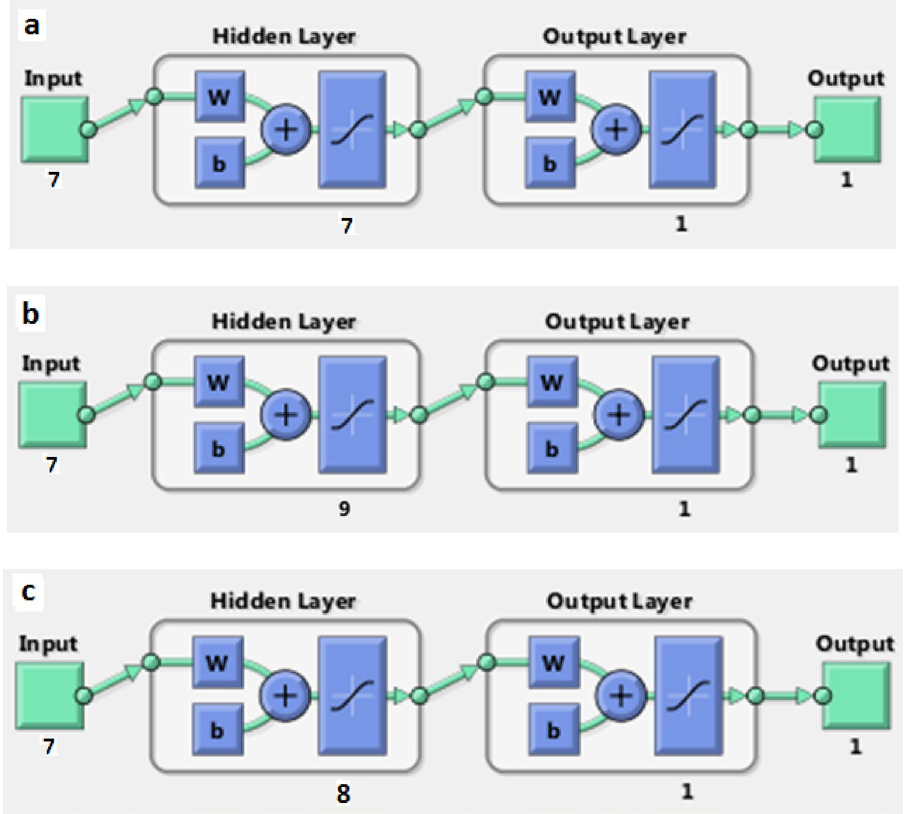
Figure 2. The plot of optimum structure of ANN. ( a ) Acintobacter , ( b ) Acromobacter and ( c ) consortium.